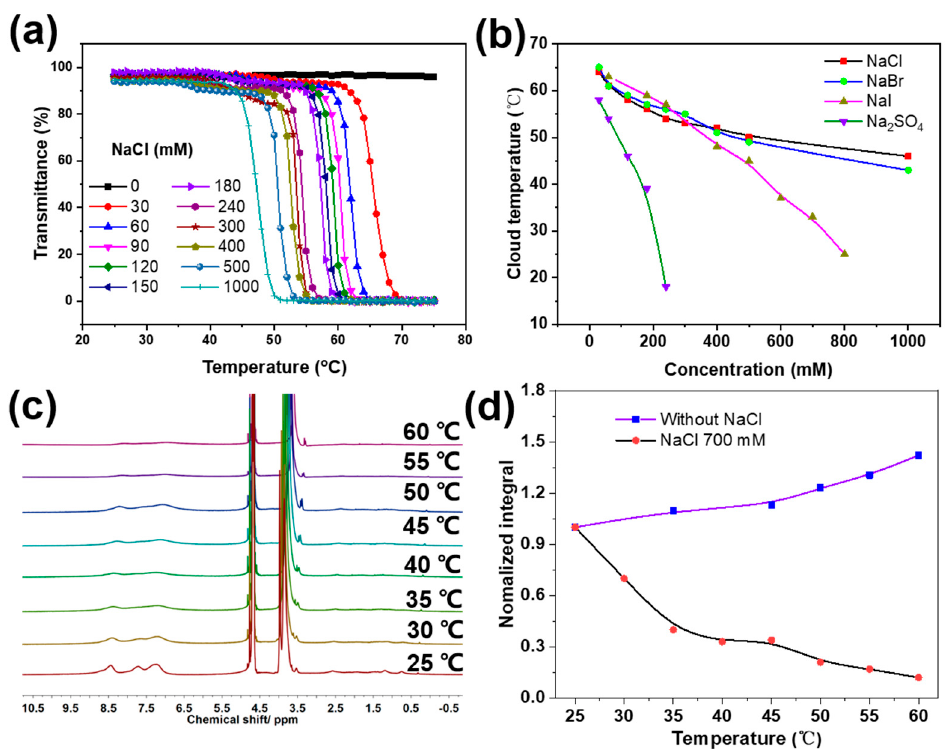
Figure 2. ( a ) Effect of NaCl concentration on the thermal response of P2. ( b ) Effect of various salts on the temperature–responsive behaviors of P2. ( c ) 1 H NMR spectra of P2 at various temperatures with NaCl concentrations at 700 mM. ( d ) Plots of the integration area of the protons on the pyridine ring versus temperature with (black line) and without (purple line) NaCl.